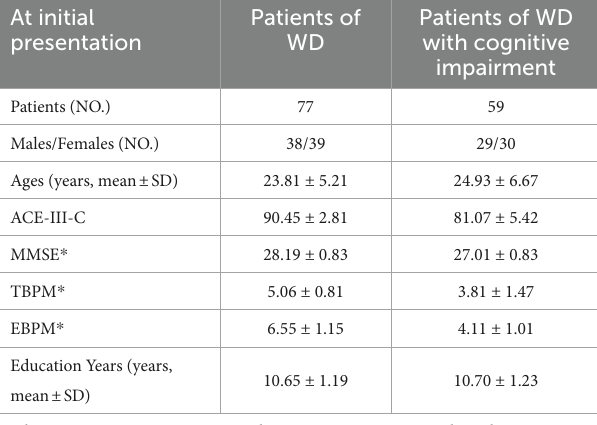
TABLE 1 Clinical and biochemical characteristics of patients. At initial presentation